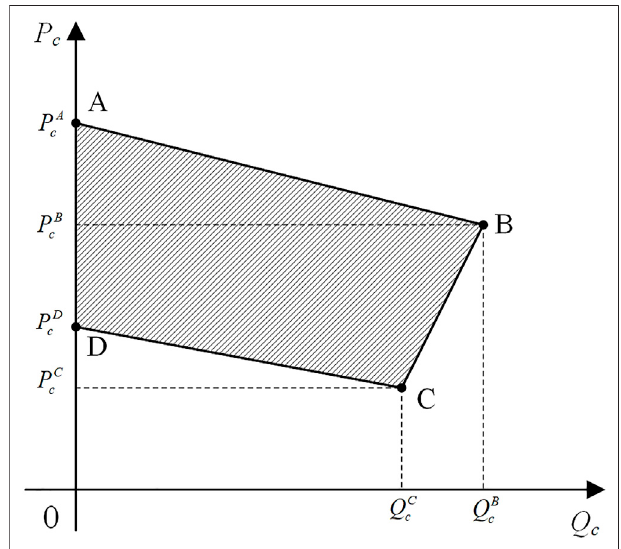
FIGURE 1 | Operable domain of